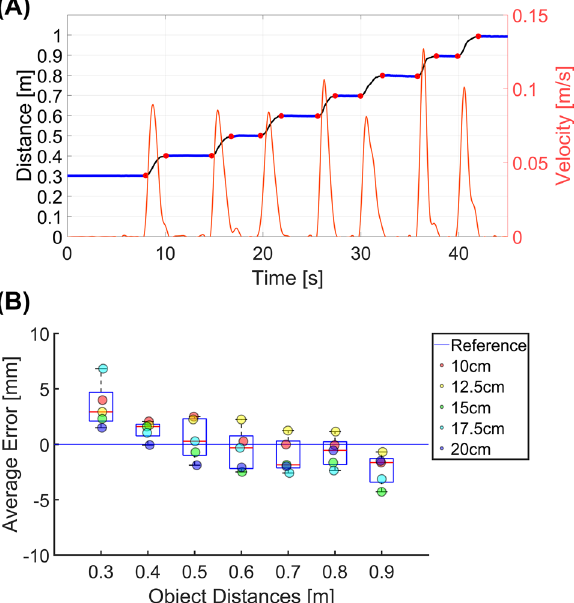
Figure 6. Experiment 1 results. ( A ) An example result from a 15 cm baseline setting. On the left y-axis, the distance between the left camera and the object is shown. On the right y-axis, the tangential velocity profile is shown. Blue lines indicate when the green ball was not moving. Black lines indicate when the green was moving. Red dots indicate the movement onset and offset of the green ball based on the velocity profile. ( B ) Average distance estimation error at different distances and baselines. Boxplot indicates the distance estimation error distribution at each object’s distance from the camera. The Scatter plot indicates the distance estimation error at different baseline settings.